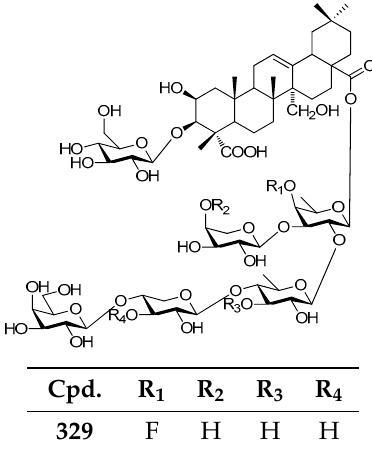
Cpd. Figure 67. Structures of compounds 325 – 328 . Figure 67. Structures of compounds 325 – 328 . Figure 67. Structures of compounds 325 – 328 . Figure 67. Structures of compounds 325 – 328 .